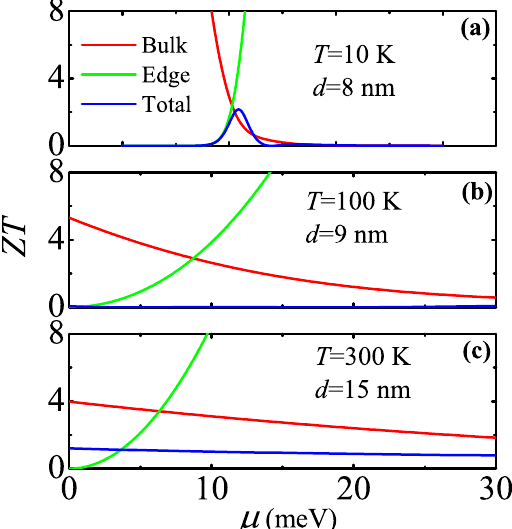
Figure 4. TE figure of merit ZT as a function of the chemical potential for various QWs in the TI regime at different temperatures: ( a ) T = 10 K and d = 8 nm, ( b ) T = 100 K and d = 9 nm, and ( c ) T = 300 K and d = 15 nm. Here, the black dashed line represents the bulk band-edge, the red and green solid lines represent the edge-state and bulk-state contributions to the TE transport, respectively, and the blue solid line represents the total TE